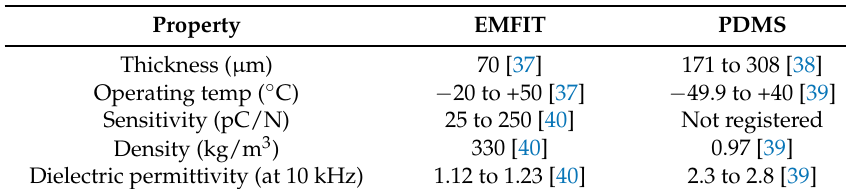
Table 2. Dielectric Material properties.